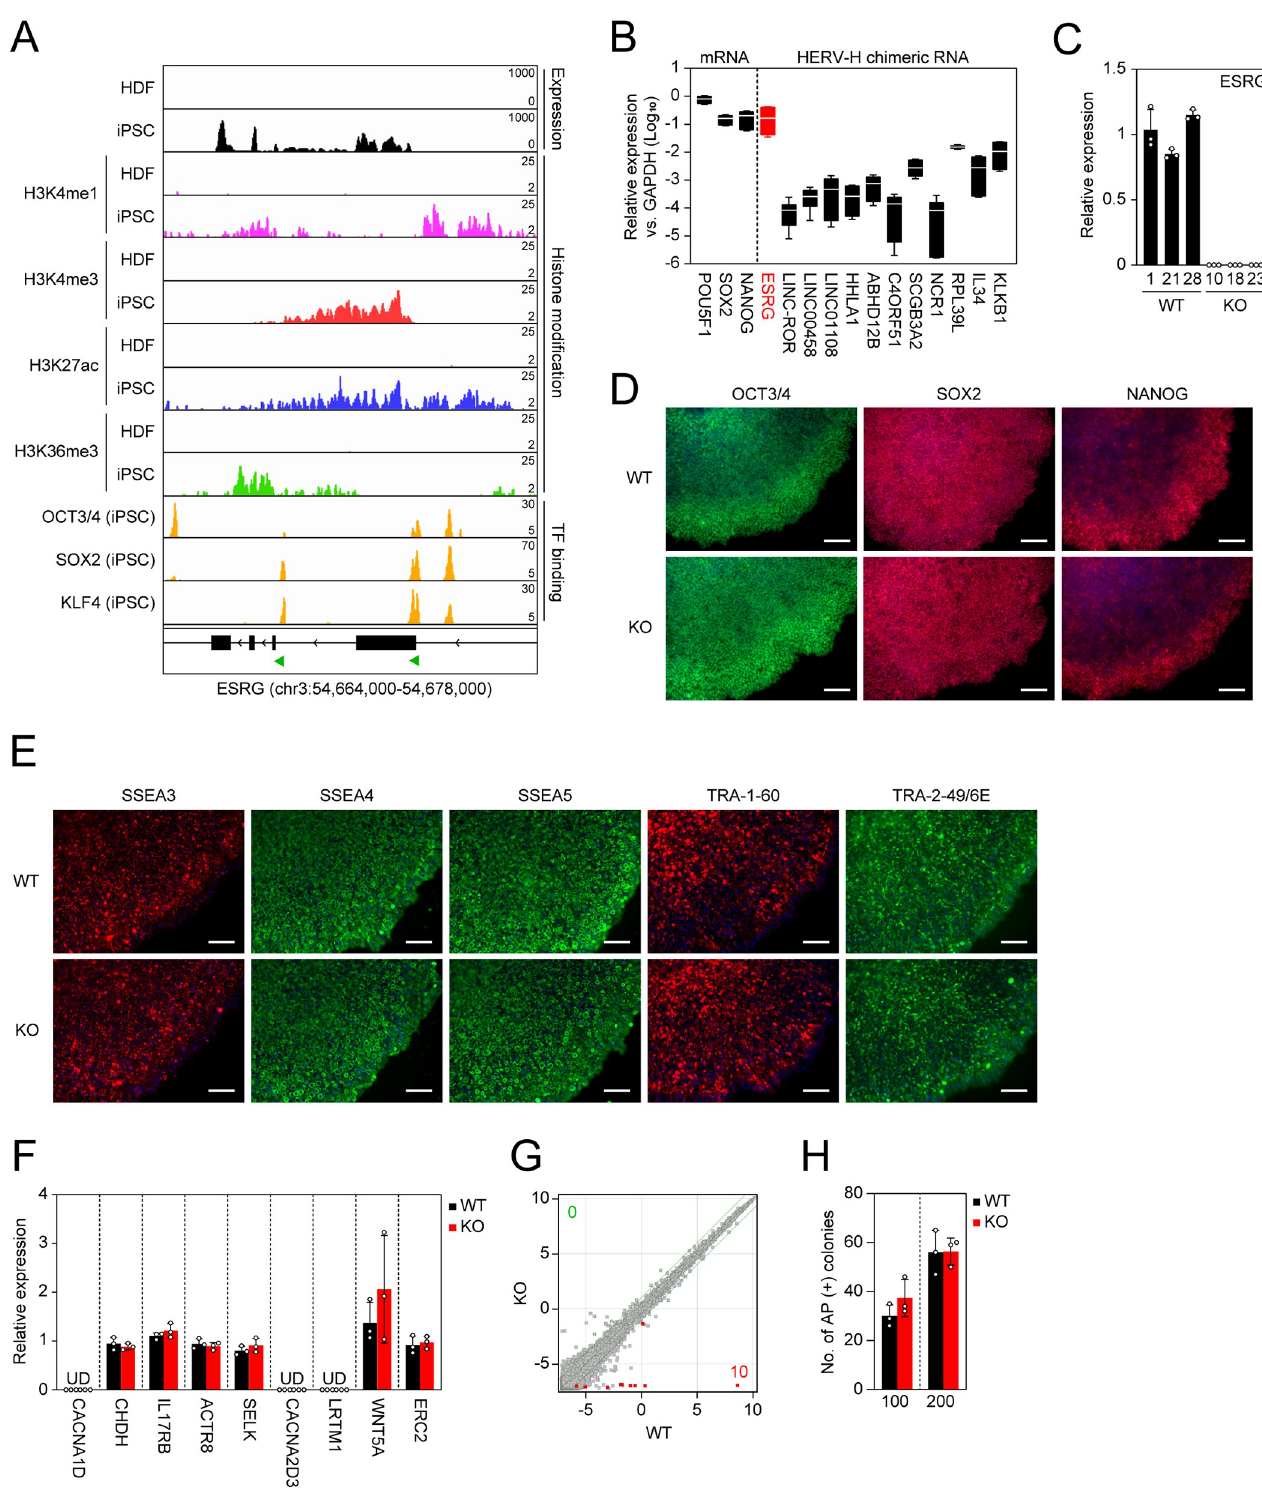
Fig 2. ESRG is dispensable for primed pluripotency. (A) Epigenetic status of the ESRG locus. We used the published RNA-seq (GSE56568) and ChIP-seq (GSE56567, GSE89976) data to confirm the RNA expression and the statuses of histone modifications and PSC core transcription factor (TF) binding on the ESRG locus in HDFs and iPSCs on human genome assembly hg19. The green arrowheads at the bottom indicate the location of the LTR7 elements. (B) Expression of PSC-associated mRNAs and HERV-H chimeric RNAs. Shown are the averaged expressions of the indicated transcripts in H9 ESCs, 585A1